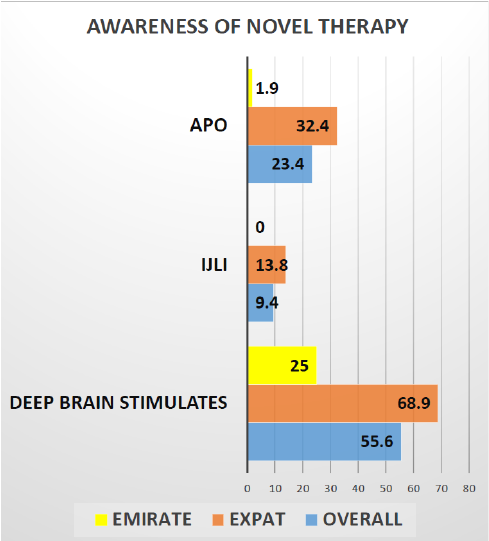
Figure 2. Graphical representation of the awareness of novel therapies in PD treatment among the Emiratis and Expats. This graph shows only 25% of Emirates are aware of deep brain stimulation test compared to 69% Expats and 2% of Emirates are aware of Apomorphine pump treatment compared to 32% of Expats. Whereas Not even a single ( 0%) Emirati is aware of Ileo-jejunal levodopa infusion compared to 13% of expats.